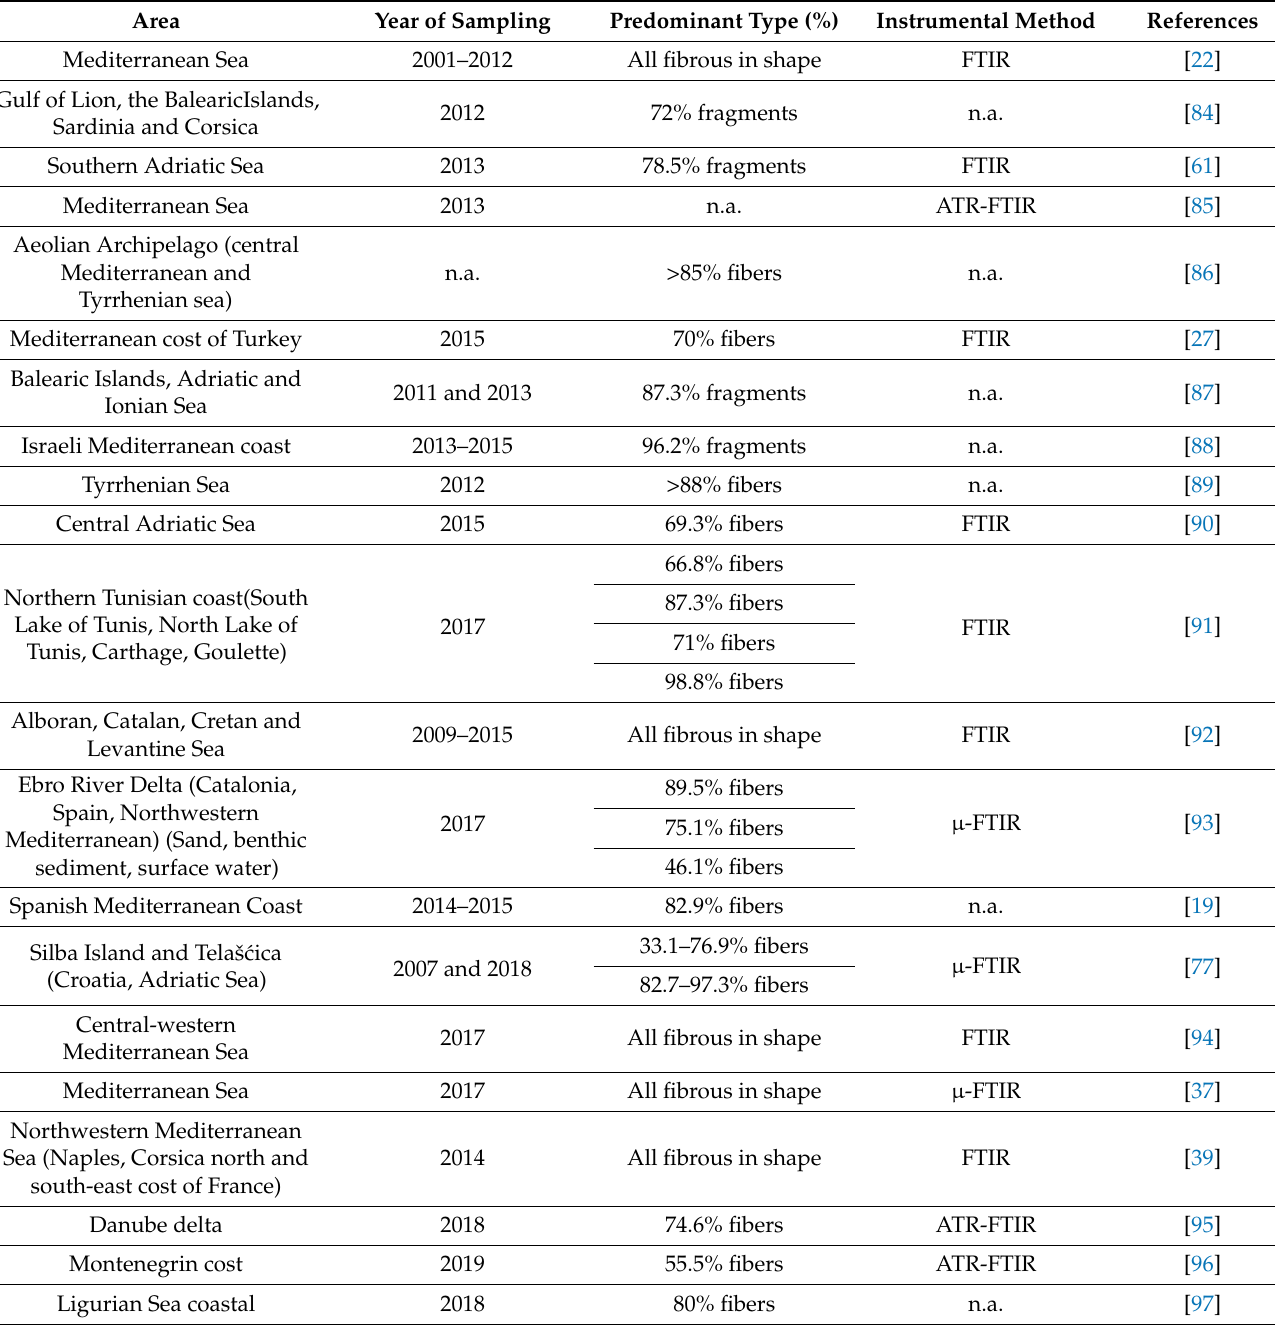
Table 2. Literature review about percentages of the predominant type of microplastic (fibers, frag- ments) in the Mediterranean Sea, region and year of sampling and instrumental method for charac- terization of MPs in sediments and